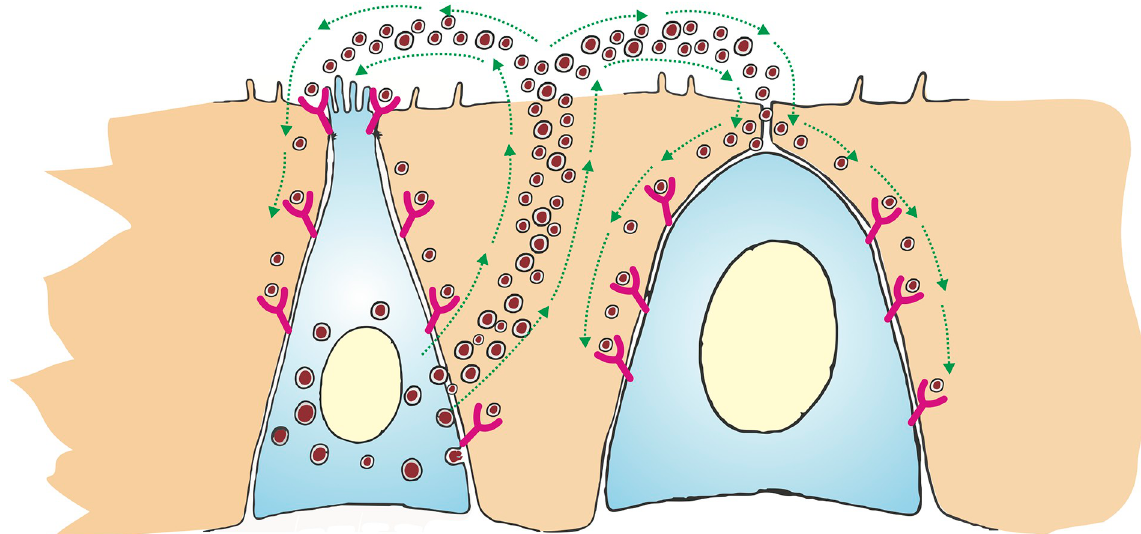
Fig 2. Schematic of paracrine and autocrine model. The secretory peptides (bombesin, glucagon, somatostatin, cholecystokinin and gastrin) or growth factors (platelet-derived growth factor, epidermal growth factor, transforming growth factor, insulin-like growth factor and fibroblast growth factor) produced by neuroendocrine cell tumors (Left cell) influence tissue growth with subsequent transformation into neoplastic cells (Right cell).